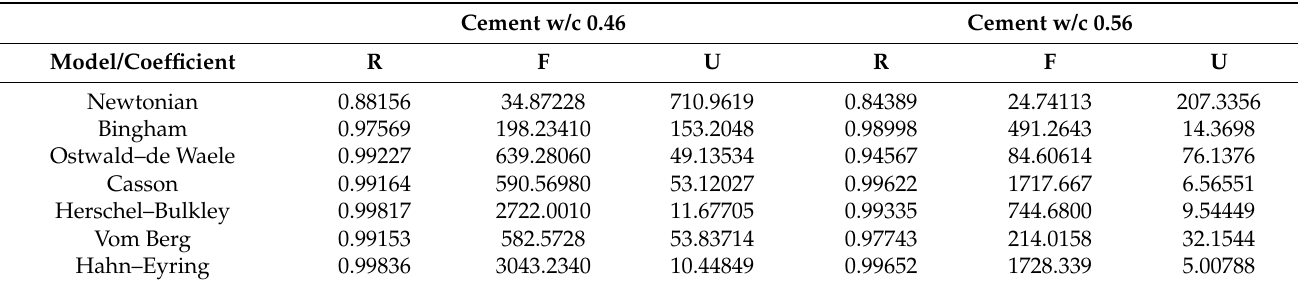
Table 6. Results of the rheological model selection obtained from Rheosolution for cement slurry samples. Cement w/c 0.46 Cement w/c 0.56